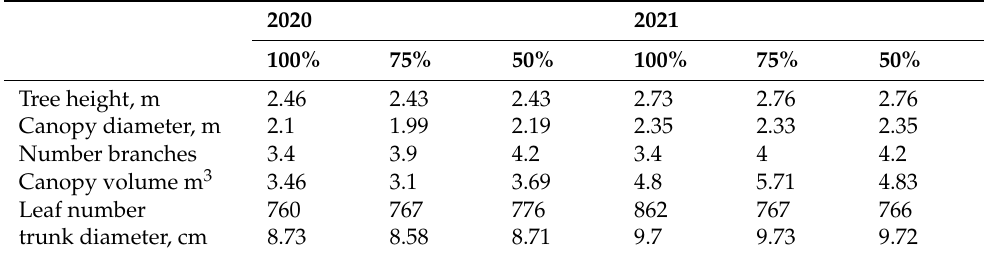
Table 3. Average tree height, trunk and canopy diameter, number of leaves, canopy volume, and number of branches of high-density trees used for different irrigation treatments after the 2020 and 2021 harvest.